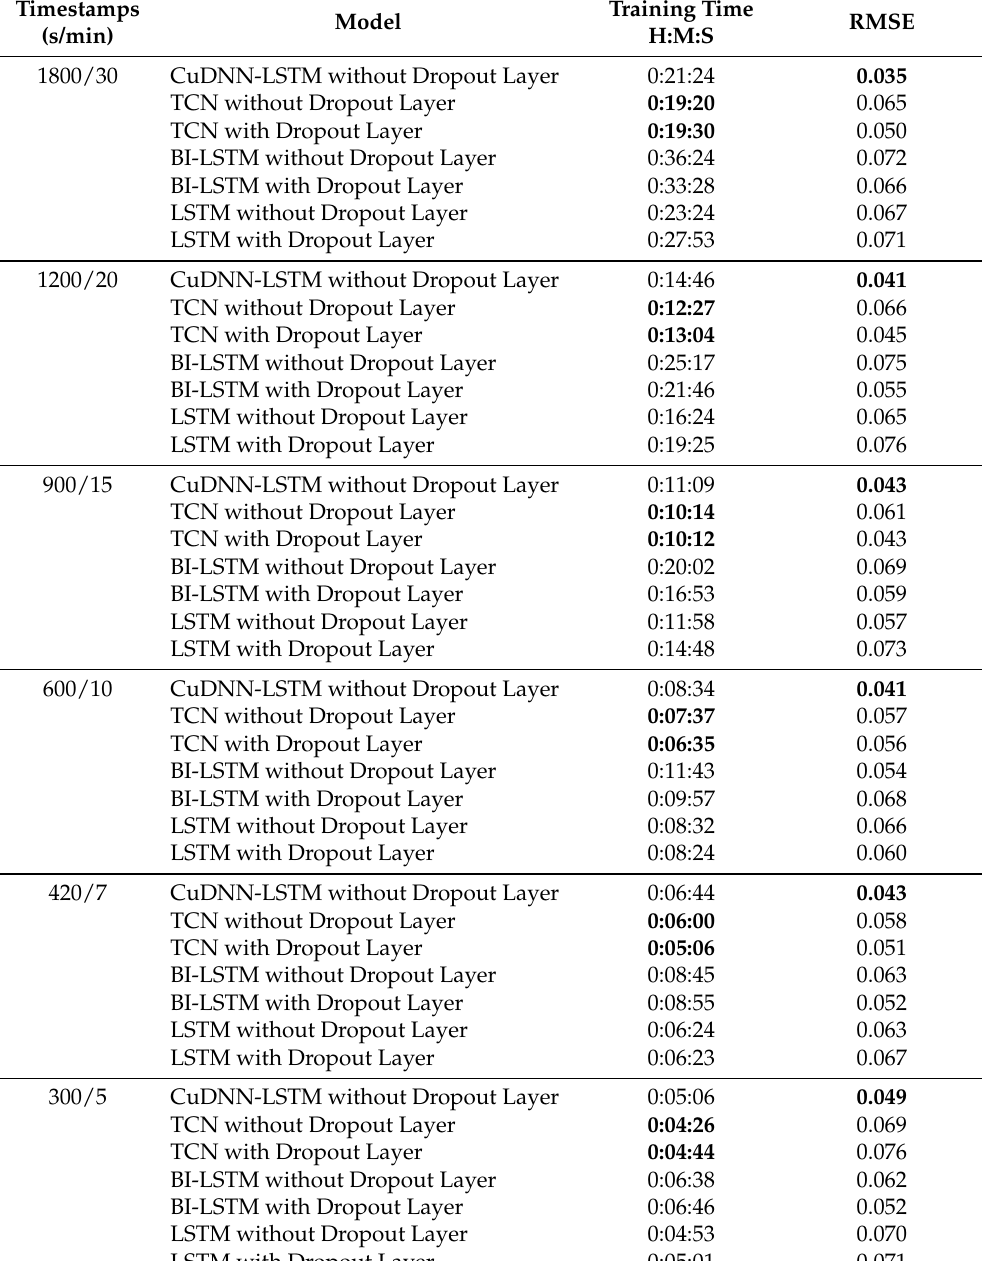
Table 1. Training time/RMSE for 30, 20, 15, 10, 7 and 5 min